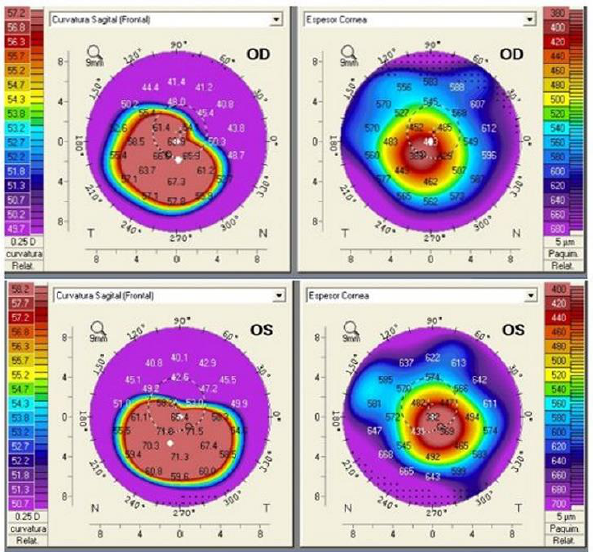
Figure 1 : Corneal topography of the patient, upon first consultation at our hospital, showing a maximum keratometry value of 72.6D on OD (a), and minimal corneal thickness of 378 μm (b). On OS, maximum keratometry value of 75.3D (c), and minimal corneal thickness of 359 μm (d).